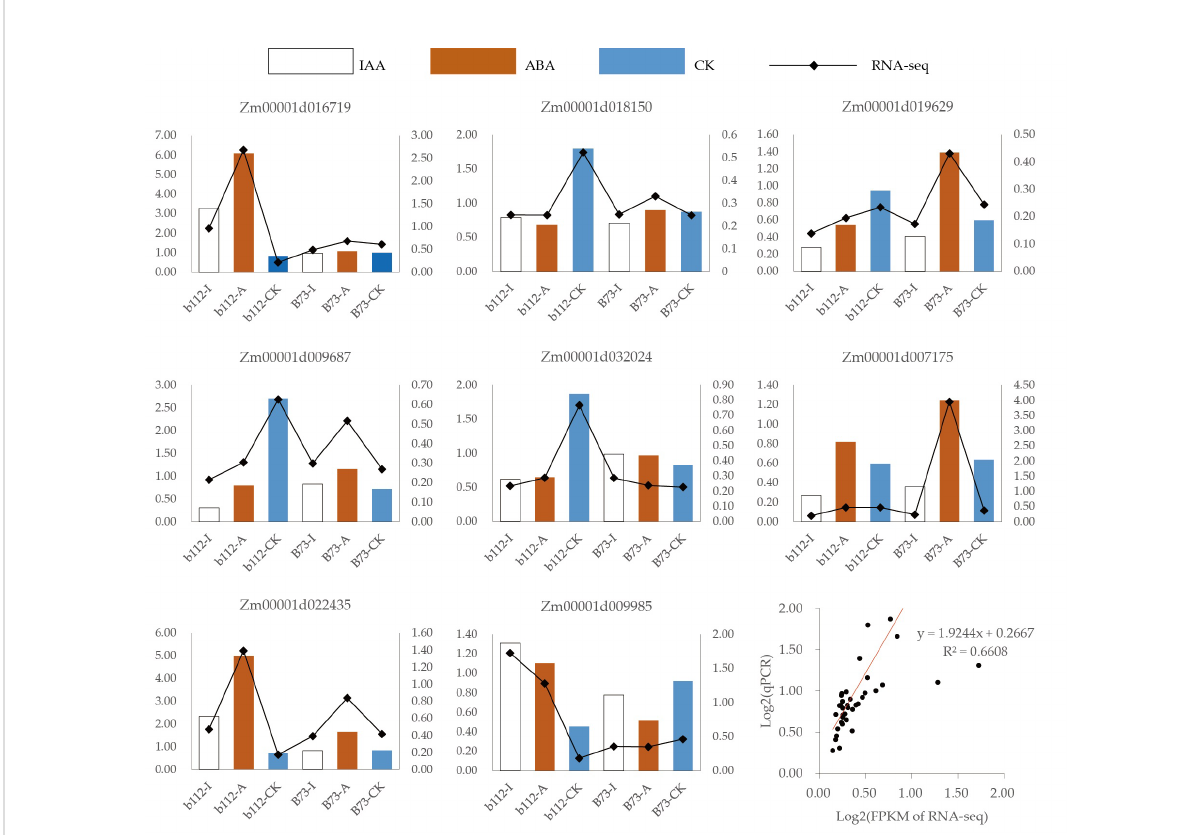
FIGURE 7 qRT-PCR was performed using 8 randomly selected DEGs. Bar and line graphs represent the qRT-PCR and RNA-Seq data,